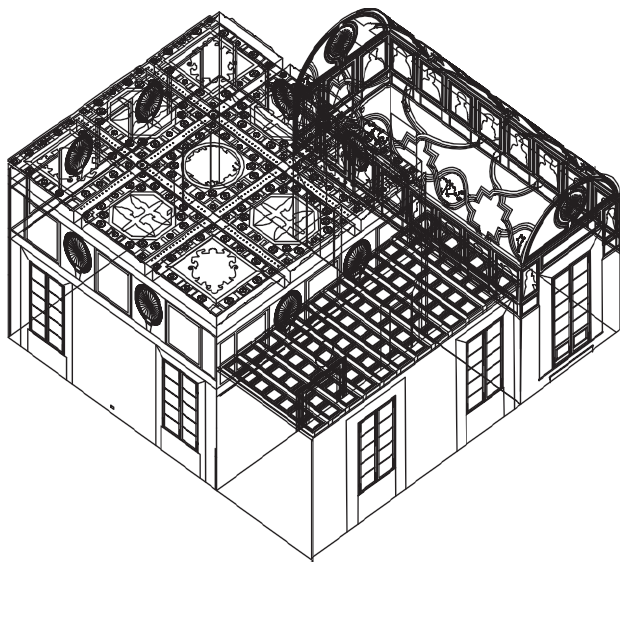
Figure 4. Axonometric view in wire